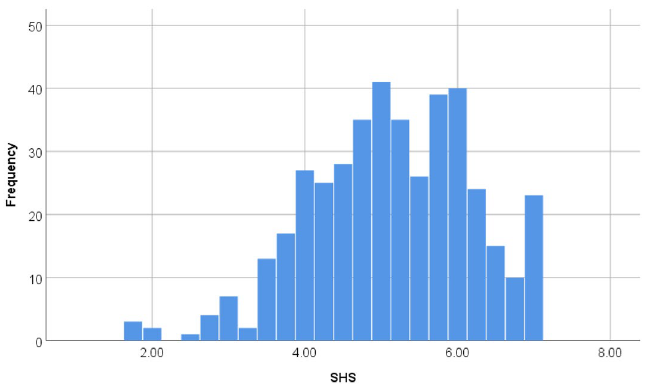
Figure 2. Distribution of SHS